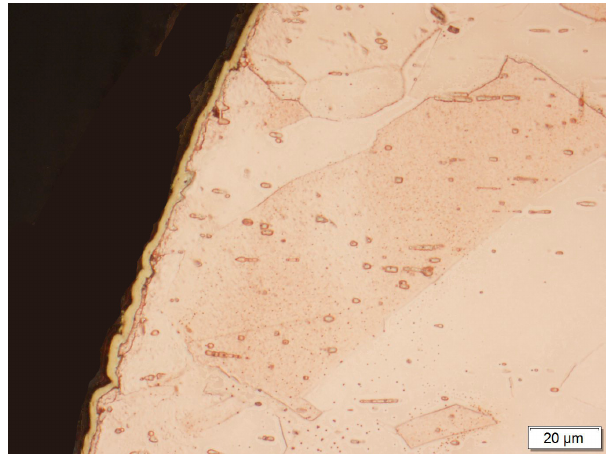
Figure 5. A gold layer applied galvanically to the surface of the copper electrode. Materials 2019 , 12 , x FOR PEER REVIEW